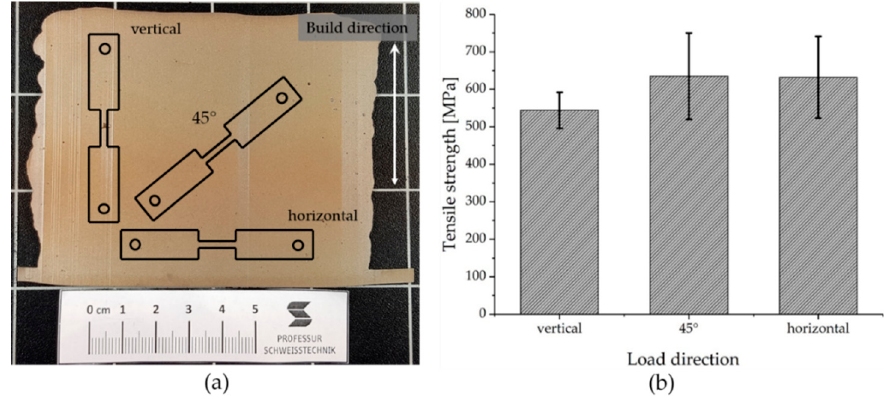
Figure 5. Overview of the influence of the loading direction on the tensile strength, condition: As-welded, ( a ) schematic of the tensile test specimen orientation, ( b ) results of the tensile tests.